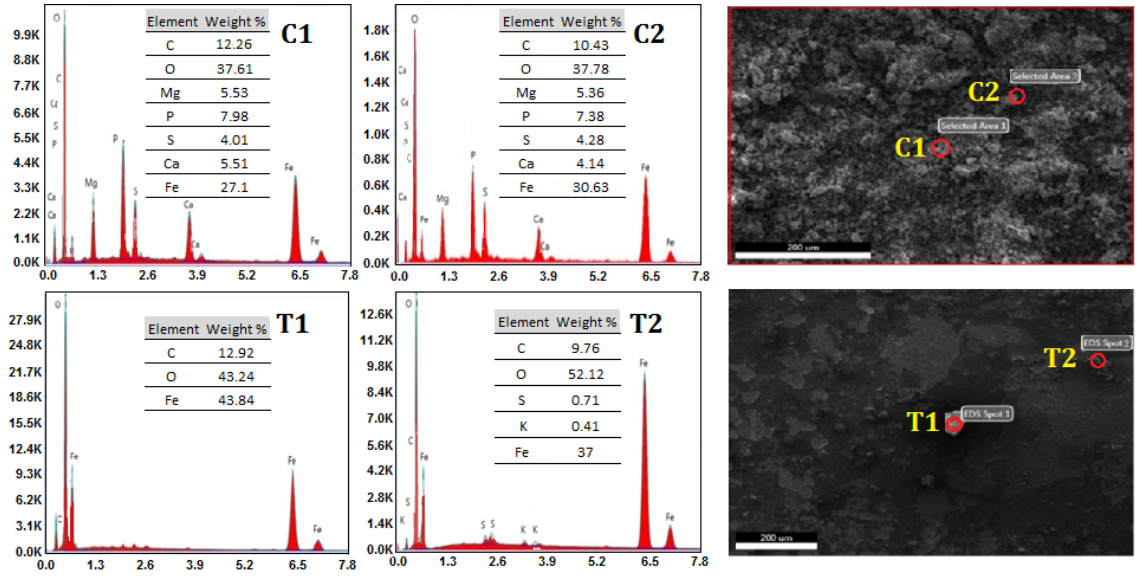
Figure 3. EDS analysis spectrum and the chemical composition for the deposits formed on N80 steel samples incubated in SRB contaminated anaerobic environment for 90 days at 37 °C (Control) (C1 and C2), and incubated in SRB contaminated anaerobic environment for 60 days at 37 °C then treated by biocide2 CHIMEC 7660 and left for another 30 days at 37 °C (Treatment) (T1 and